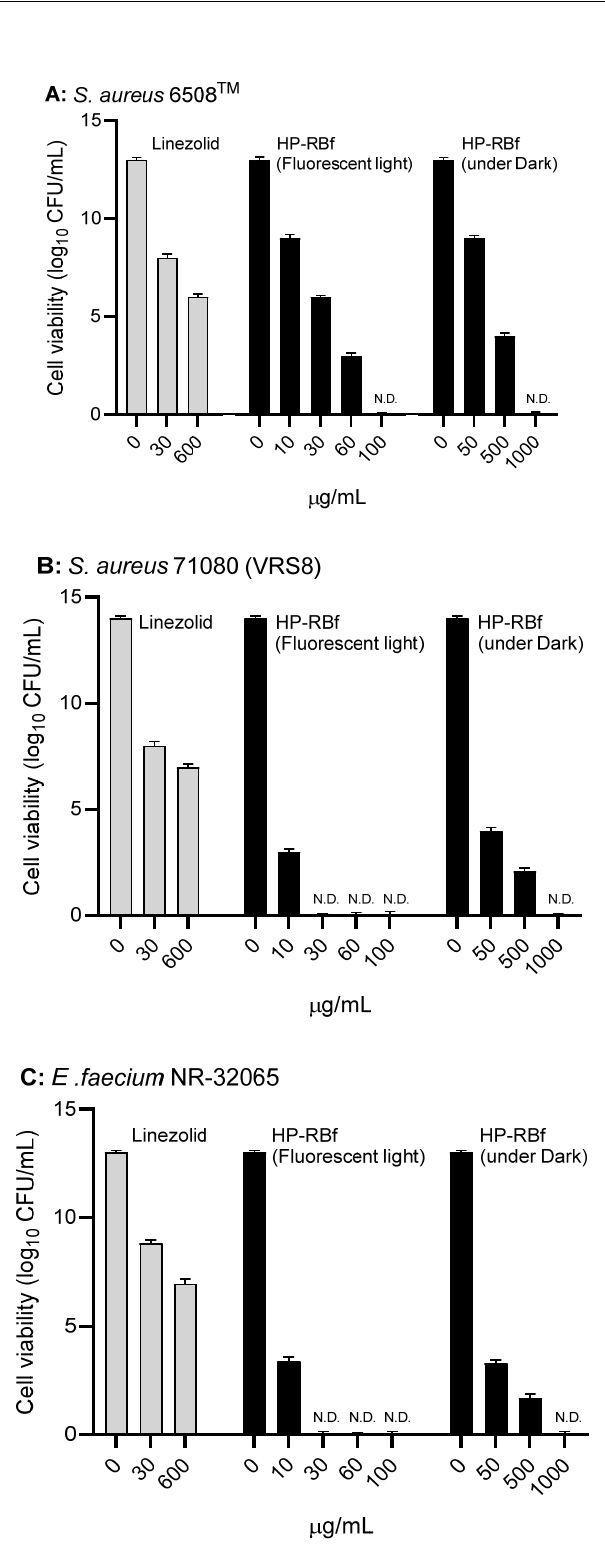
Figure 3. Anti-biofilm activity of HP-RBf against Gram-positive bacteria. ( A ) Anti-biofilm activity of HP-RBf against S. aureus 6538 TM ; ( B ) Anti-biofilm activity of HP-RBf against S. aureus 71080(VRS8); ( C ) Anti-biofilm activity of HP-RBf against E. faecium NR-32065.